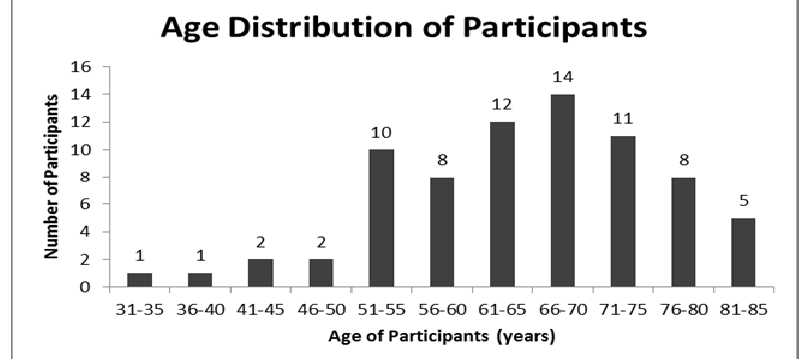
Figure 1. Age distribution of participants.